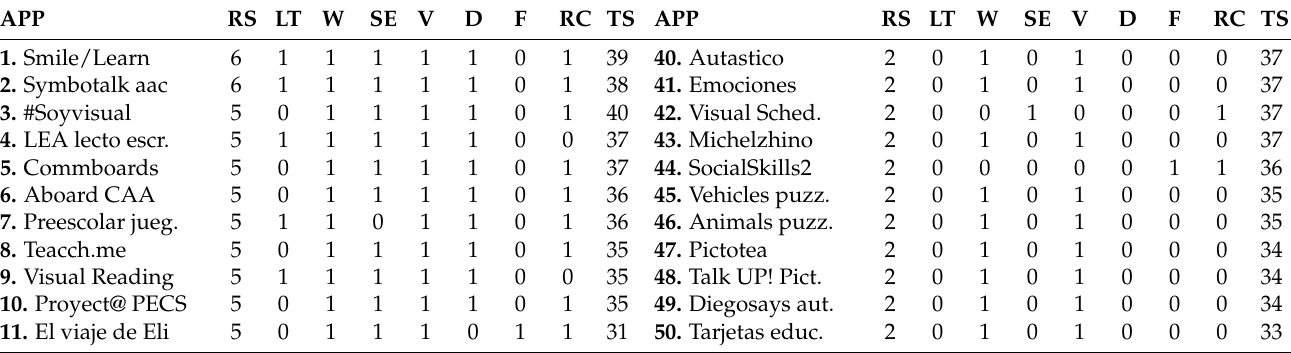
Table 6. Apps focused on reading, ordered according to the score obtained in this skill and the sub-areas it comprises.